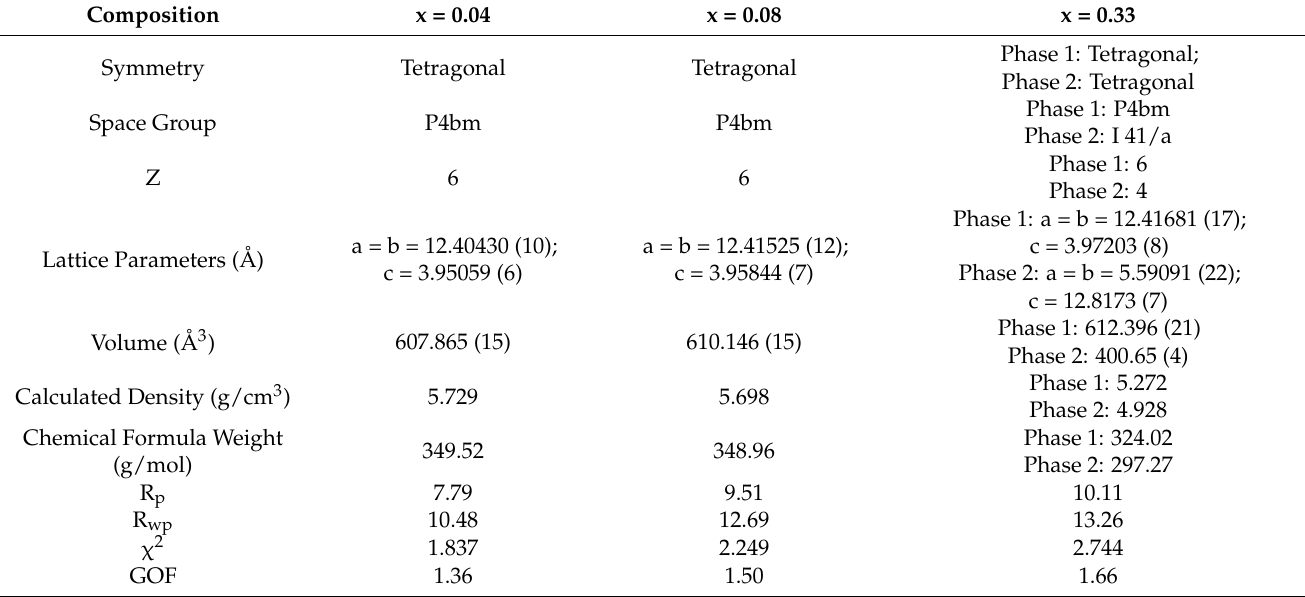
Table 1. The data from the Rietveld refinement for the crystalline phases of the Ba 0.54 Na